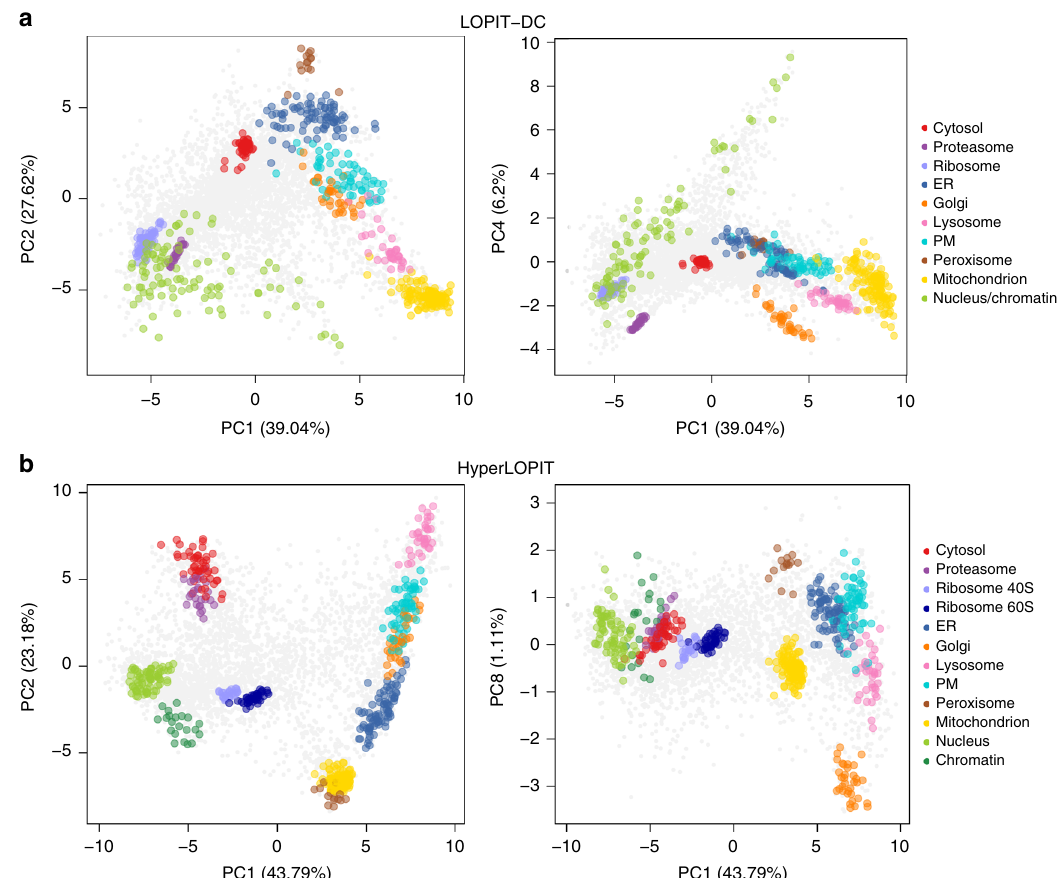
Fig. 2 LOPIT-DC resolves all major subcellular niches. a , b Principal component analysis (PCA) projections for the LOPIT-DC ( a ) and hyperLOPIT ( b ) datasets. Subcellular marker proteins are highlighted as indicated and multiple principal components are presented to display resolution of all compartment clusters. Percentage variance explained by component is shown in